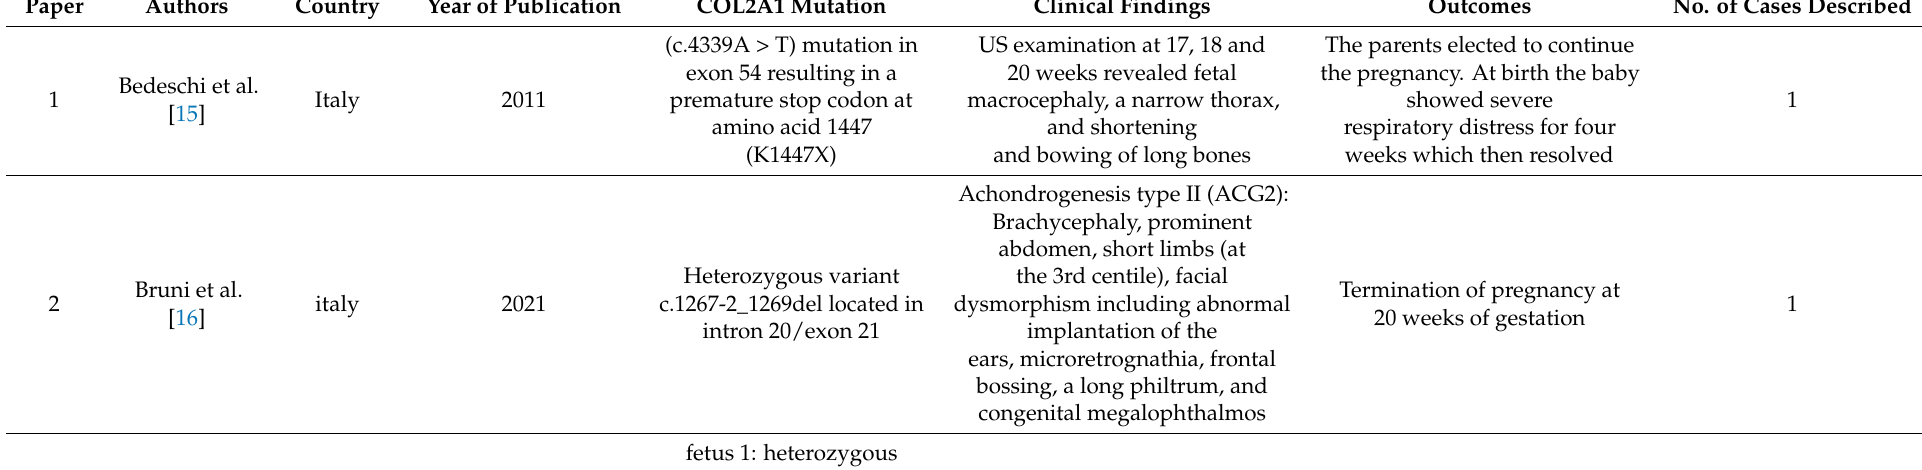
Table 1. Existing case reports associating the phenotype of short extremities with mutations/variants of the COL2A1